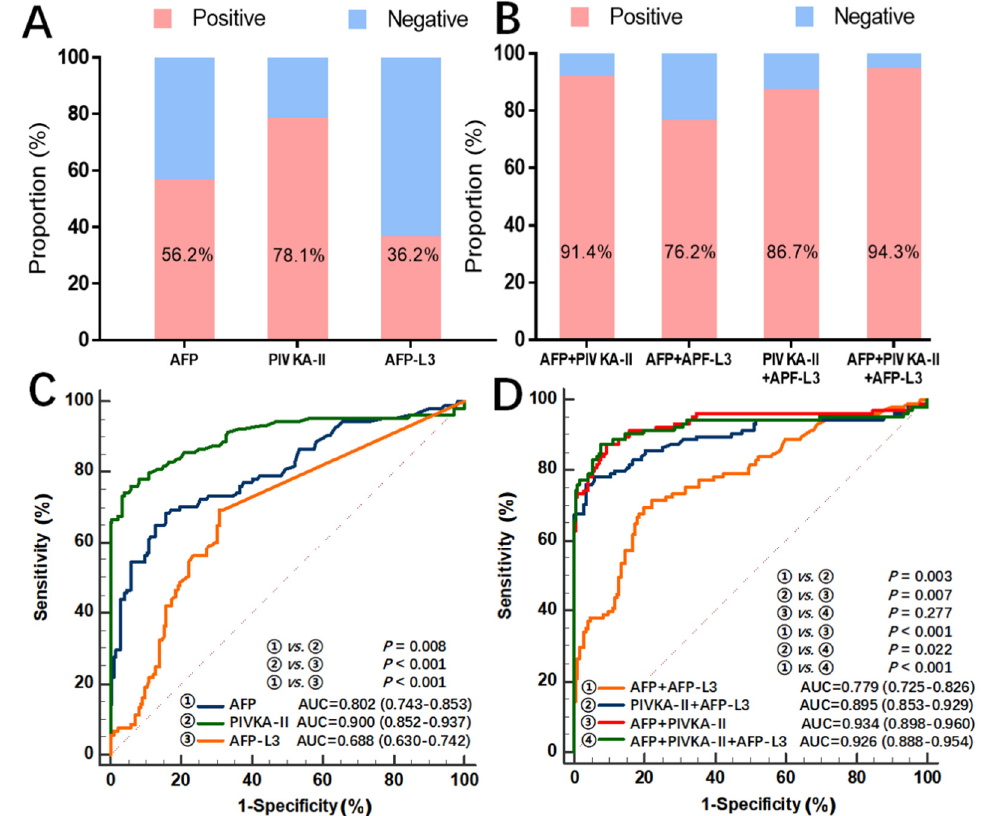
Figure 2. Diagnostic performance of three serum biomarkers alone and in combination for the detection of HCC among HCV-infected patients. ( A ) The positive rate of AFP, AFP-L3, and PIVKA-II alone using their respective clinical cut-off values; ( B ) The positive rate of their combinations of these biomarkers using their respective clinical cut-off values; ( C ) ROC curves of AFP, AFP-L3, or PIVKA-II alone; ( D ) ROC curves of any combination of two or three biomarkers. AUC, area under the curve; HCC, hepatocellular carcinoma; HCV, hepatitis C virus; ROC, receiver operating characteristic.